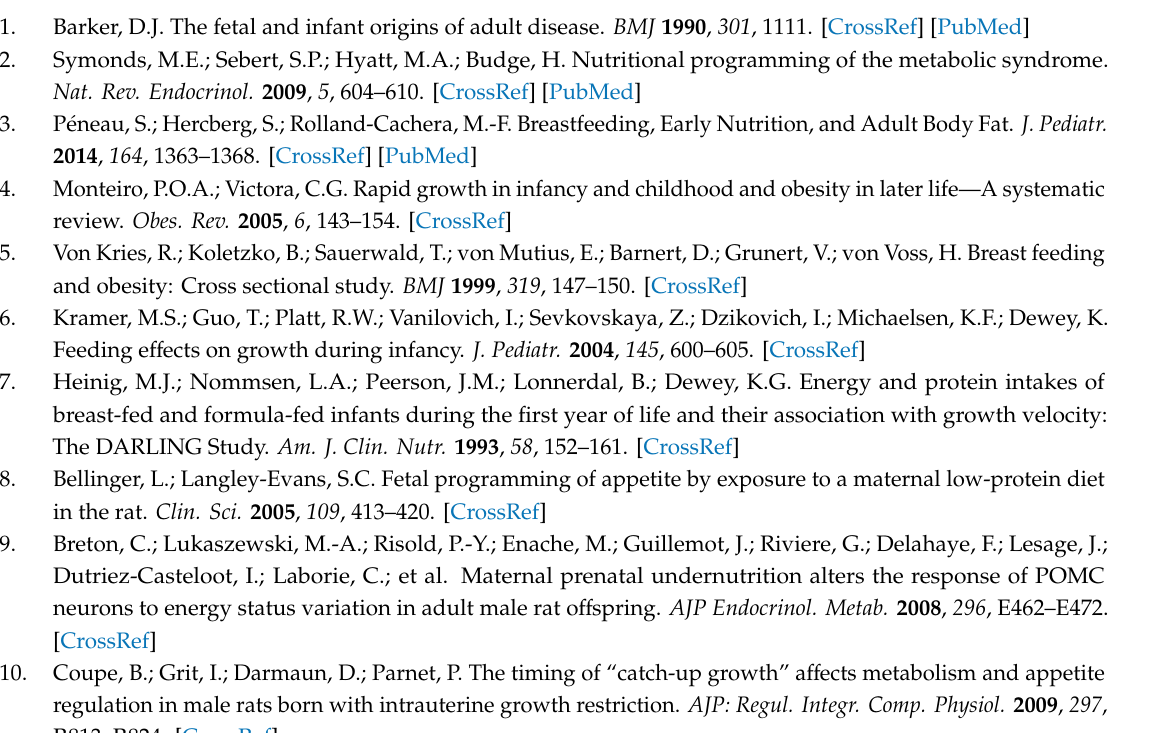
Table S1: Diet composition, Table S2: Primers, Table S3: Body weight and body composition at PND21. Adiposity is presented in absolute weight (g) and percentage of body weight (%), Table S4: Fasted plasma parameters of female rat pups at PND68, Table S5: Changes in mRNA encoding for genes in adipose tissue of fed female rat pups at PND70, Table S6: Changes in mRNA encoding for genes in hypothalamus of fed female rat pups at PND70. Ribosomal 18S RNA was used as the internal control. The results are expressed as ratio of expression with Control-NP group, Figure S1: Cumulative food intakes of mothers during the last week of gestation (a) and of mothers with their litter during lactation (PND0 to PND19) (b), Figure S2: Insulin area under curve during the OGTT at